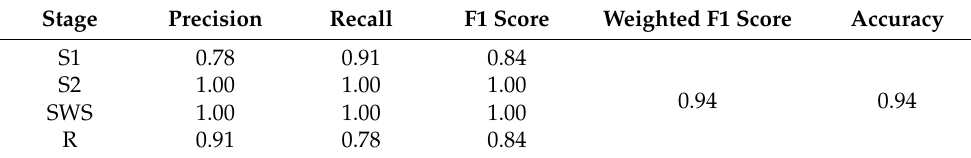
Table 4. Experiment results for test data (Exp3).